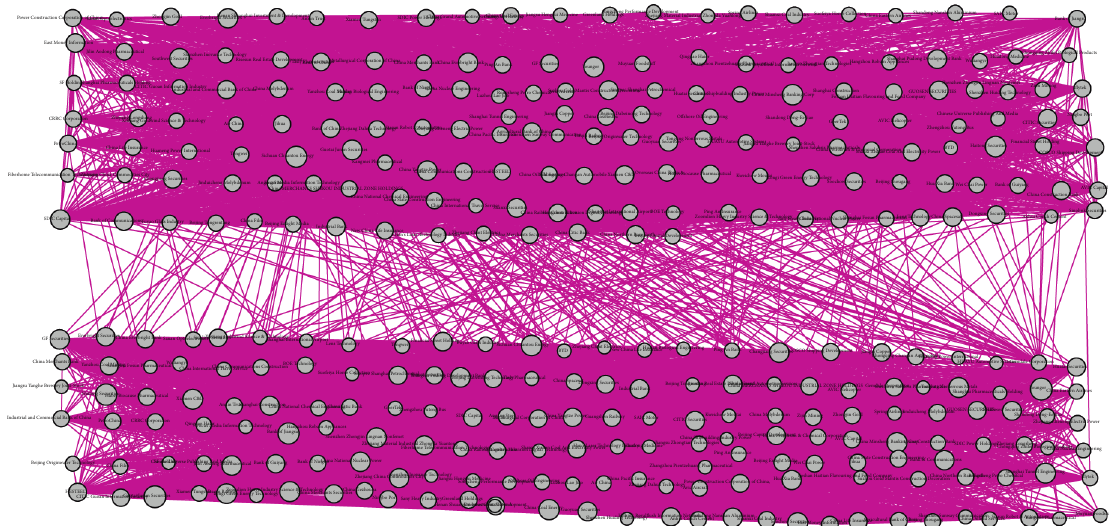
Figure 8: Temporal complex